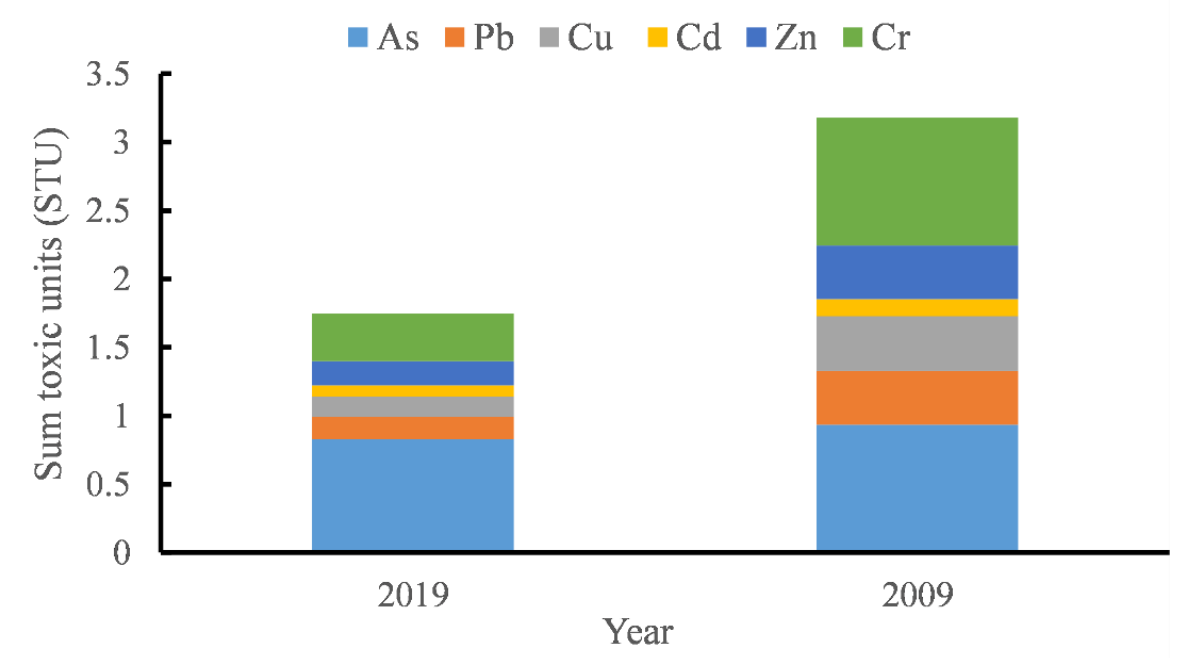
Figure 7. Sum of the toxic units in surface sediments of Huaxi Reservoir based on the data in 2019 and that of 2009 from literature [32].